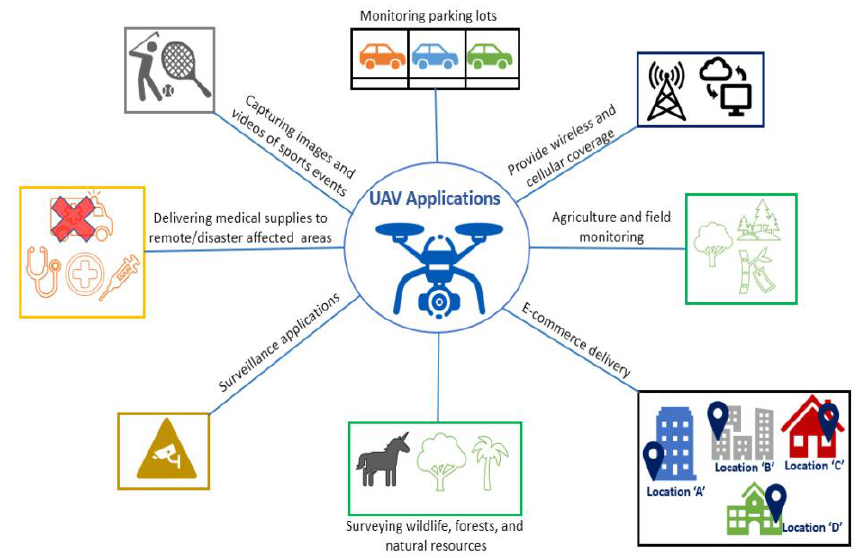
Figure 1. UAV indoor location application scenarios [26].